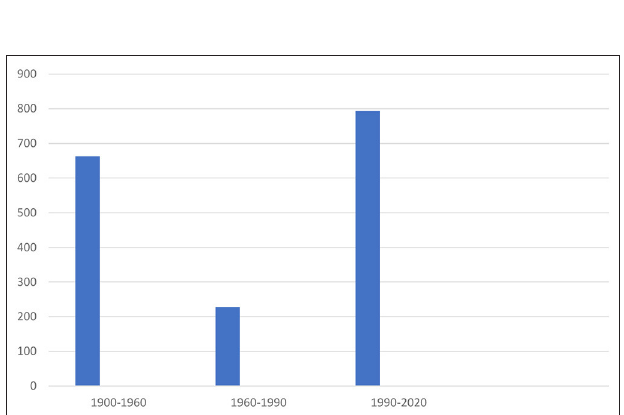
FIGURE 2 | No. of Anglicism lemmas identified in the three periods.